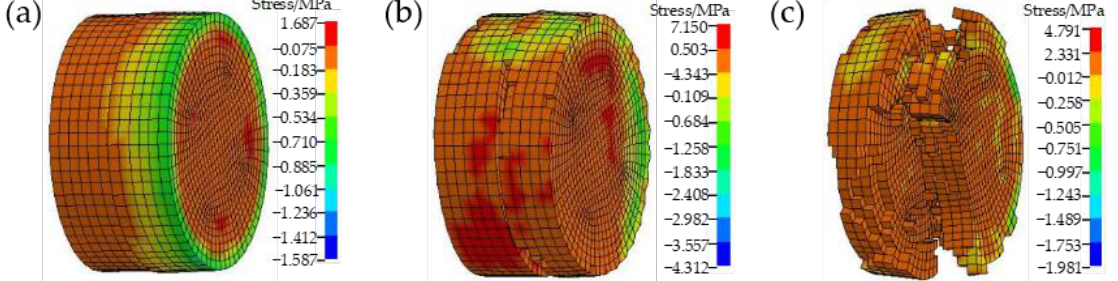
Figure 17. Stress distribution nephogram of 0° layered filling body: ( a ) failure time of 0.4 ms; ( b ) failure time of 2.1 ms; ( c ) failure time of 10 ms.